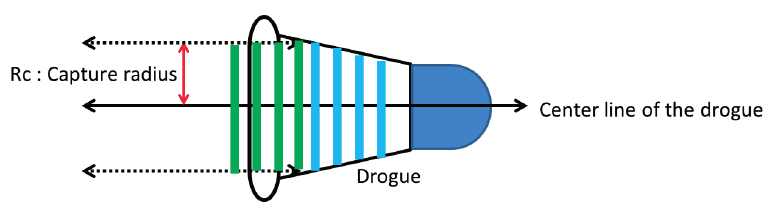
Figure 16. The catch